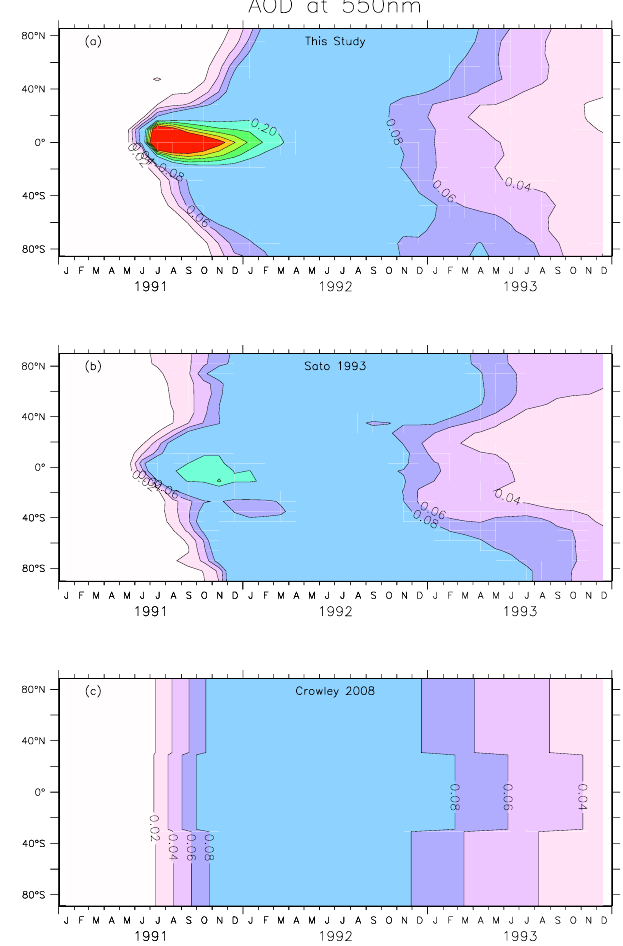
Fig. 10. Latitudinal distribution of the optical depth in VIS (550nm) for the Pinatubo eruption for this study (top panel), Sato et al. (1993) (middle panel) and Crowley et al. (2008) (lower